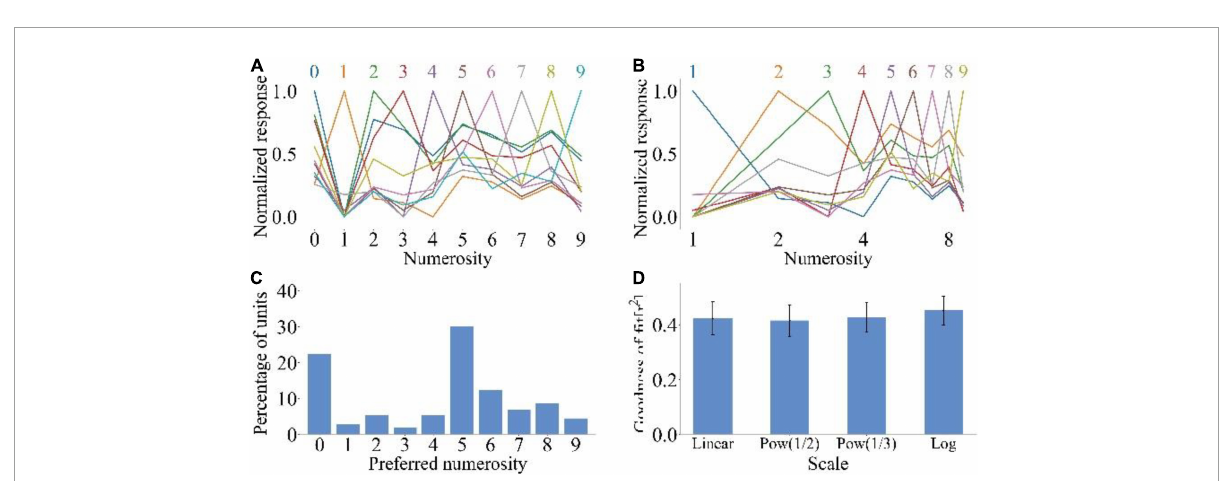
FIGURE3 Output response of spike neural network model under symbolic number dataset MNIST. (A) Average tuning curves for network units that prefer each symbolic number plotted on a linear scale. (B) Average tuning curves for network units that prefer each symbolic number plotted on a logarithmic scale. (C) Distribution of preferred numbers of number-selective network units. (D) Average goodness-of-fit measure for fitting Gaussian functions to tuning curves on different